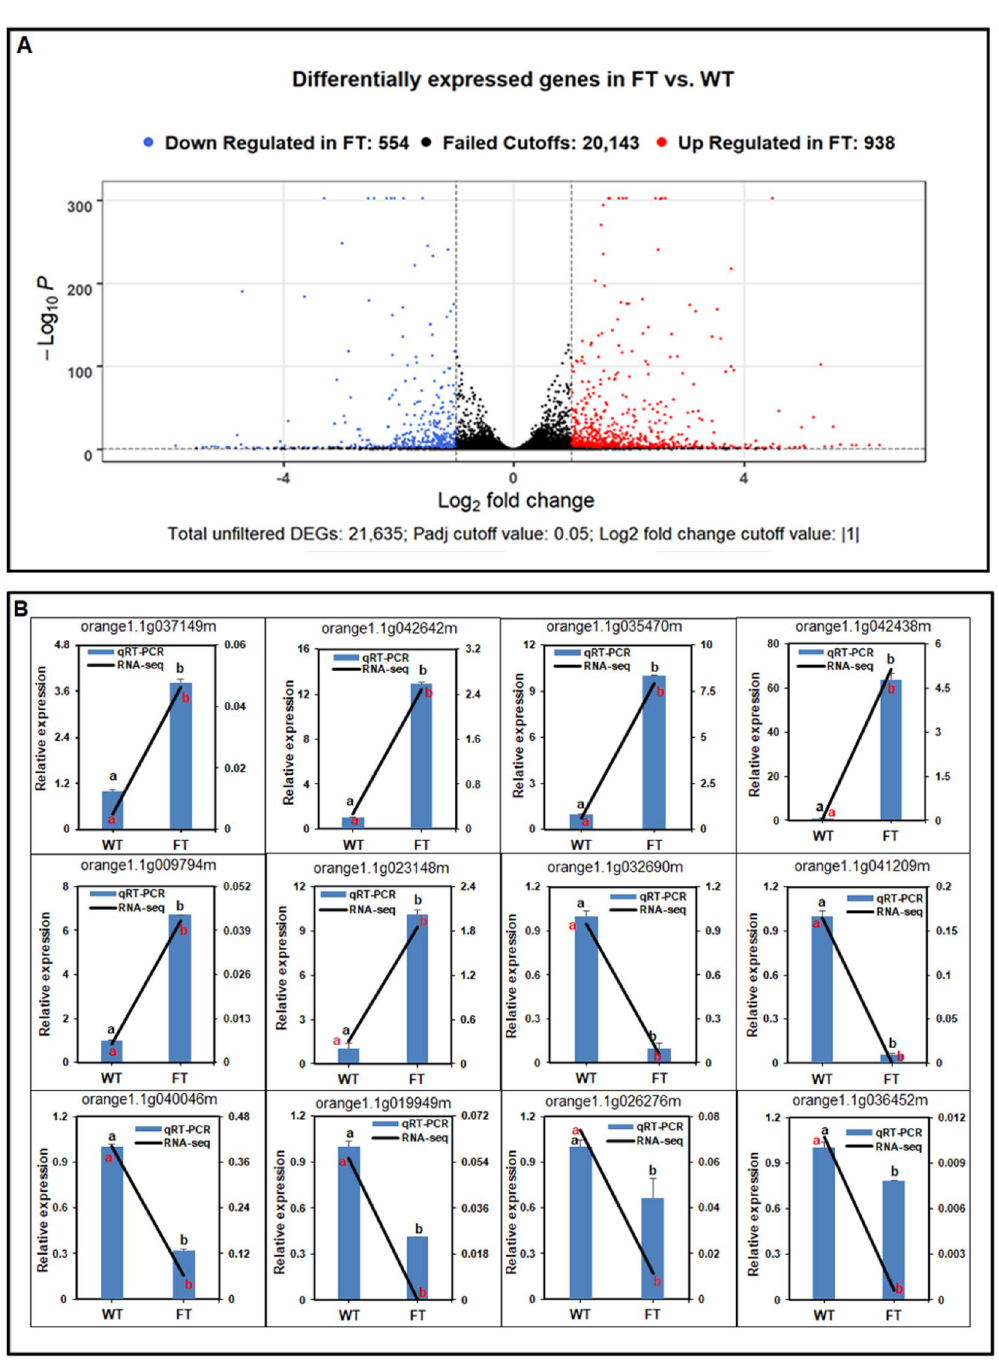
Figure 9. A volcano plot of DEGs and validation of the transcriptome analysis of selected DEGs using RT-qPCR. ( A ) Volcano plot showing the Log 2 fold change difference and the adjusted P-value for 21,635 genes included on all platforms. The red dots represent upregulated genes and the blue dots the downregulated genes in AtSUC2-CcFT3 MP3 transgenic lines (adjusted P < 0.05). ( B ) The expression levels of DEG candidates in AtSUC2-CcFT3 MP3 transgenic line was calculated using 2 -ΔΔCt and those values were compared to non- transgenic control values. Different letters (a, b) represent a significant difference at P ≤ 0.05 using Duncan’s Multiple Range Test and error bars represent SE (n = 3) for RT-qPCR (black) and RNAseq